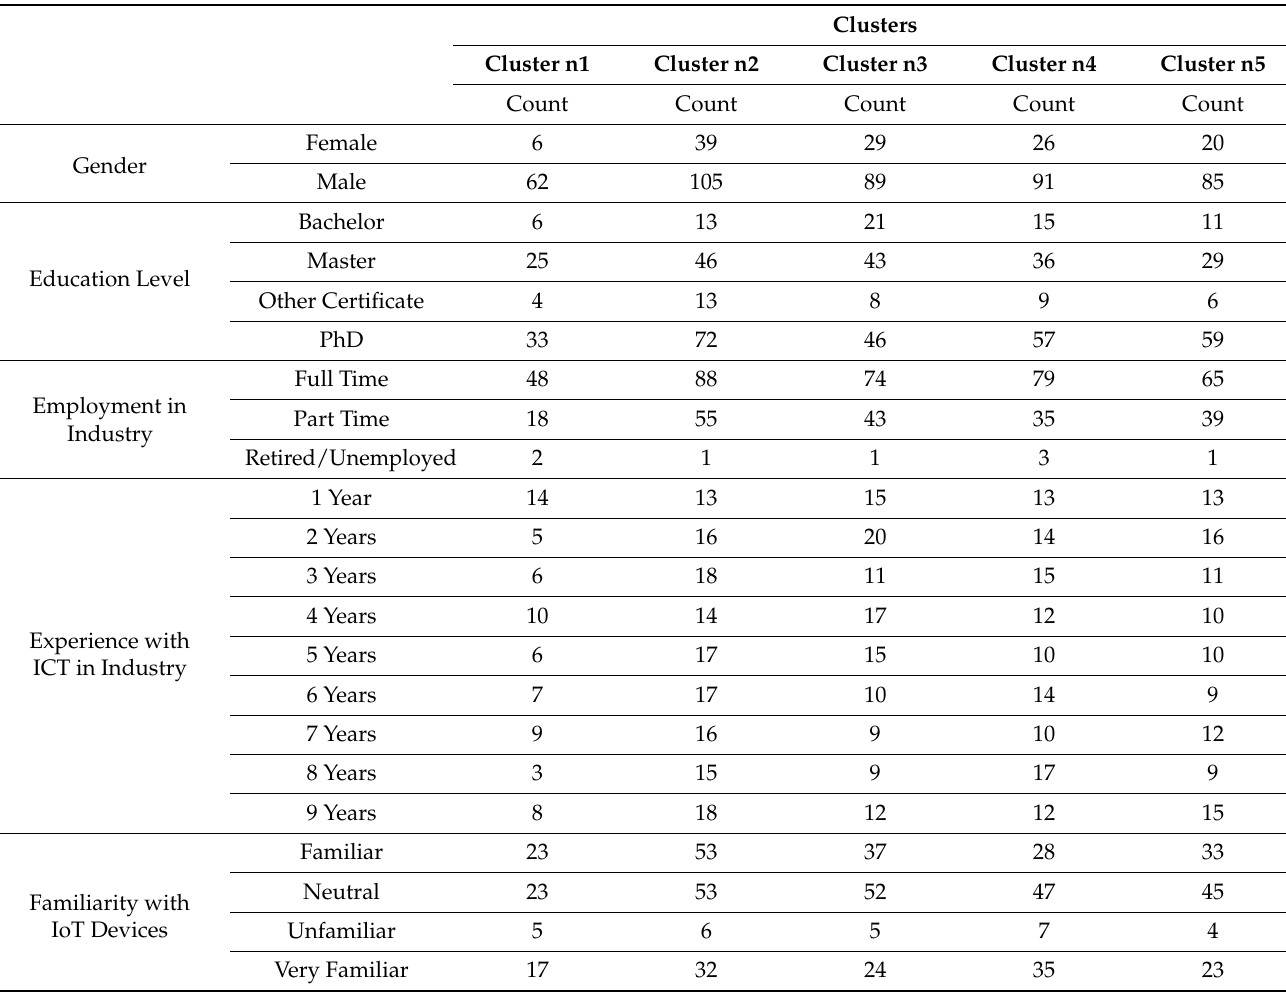
Table 9. Gender, education level, employment in industry, experience with ICT in industry, and familiarity with IoT